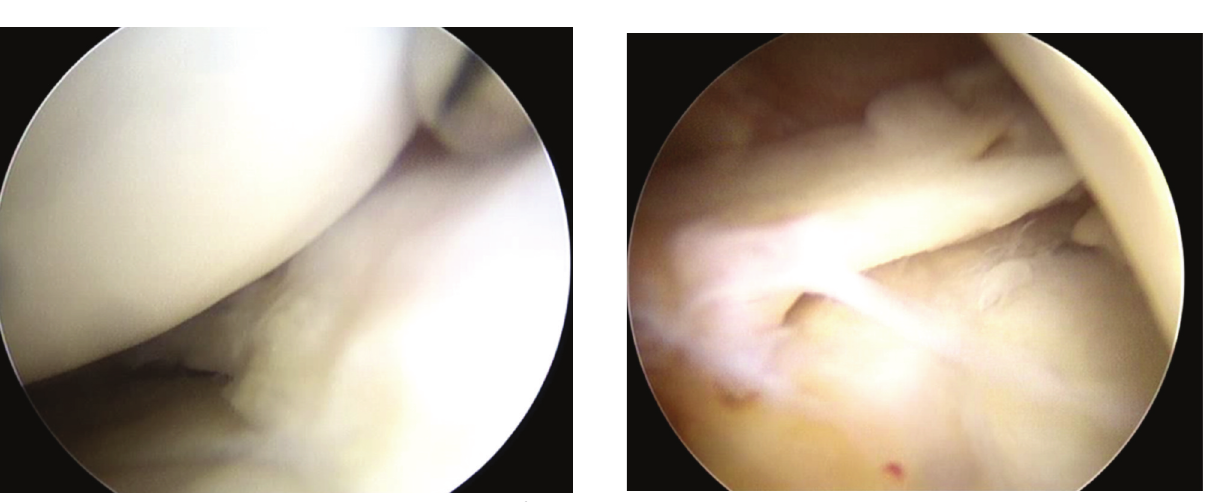
Arthroscopic image showing the integration of the Fig. 1a: meniscal implant in its body and anterior horn.